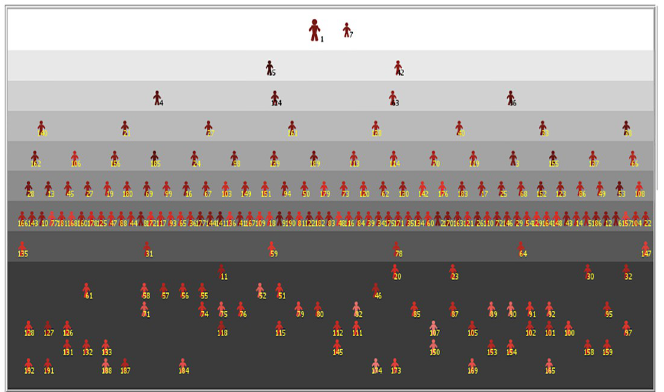
Fig 2. An example of athletes’ classification at the end of a simulated tournament. Subscripts display the initial ranking of the fencers, while their pyramidal arrangement indicates their final placements. Agents in the bottom, dark- gray, part of the figure are the 30% of athletes who did not access to the direct elimination